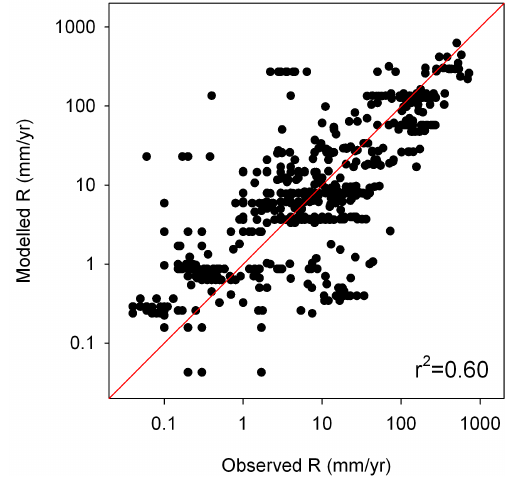
Fig. 12. Relationship between the field estimates of recharge and the estimates of recharge from the regression equations in Fig.